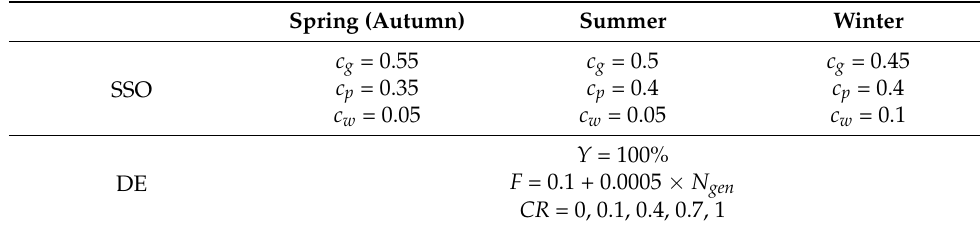
Table 17. Parameter settings for